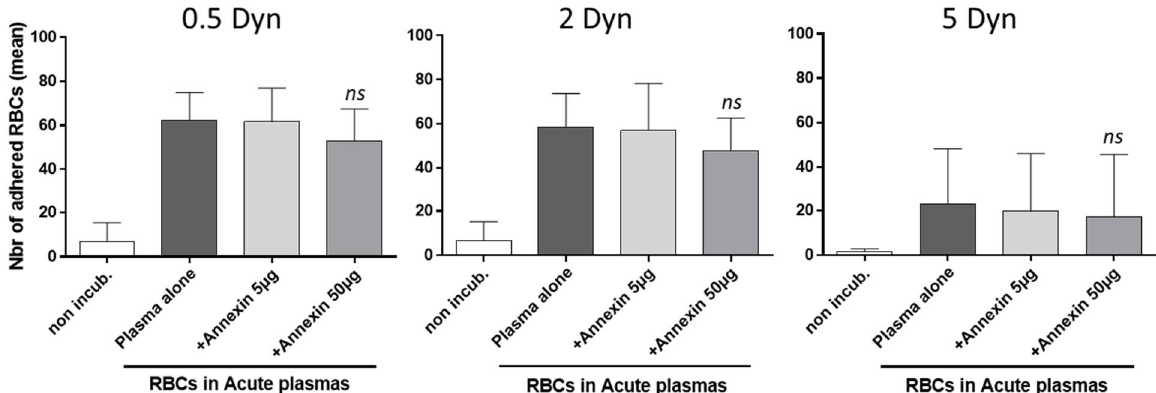
Figure 4. Adhesion results for AA RBCs to thrombospondin, whose senescence is induced by acute SCD plasmas, is not blocked by Annexin V. The adhesion of AA RBCs from blood units was tested under physiological in-flow conditions after co-incubations with plasmas from SCD patients into severe “acute” clinical conditions, using Vena8 microslides coated with TSP. RBCs were washed and resuspended in the Ca 2+ containing buffer from the kit, before processing the adhesion assay. Recombinant Annexin V (5 and 50 μg) was then added before perfusion to inhibit adhesion. We previously verified that the addition of recombinant Annexin V (5–10 μg) to fresh normal RBCs was sufficient for blocking the positive staining with Annexin V-FITC of PS-positive AA RBCs treated with the calcium ionophore A23187 (data not shown). After washouts at increasing shear stresses (first 0.5, then 2 and finally 5 Dyn/cm 2 ), adherent red cells were counted. The means of adhesion for non-incubated RBCs were 6.8 ± 8.6 for the 0.5 Dyn shear stress, 6.7 ± 8.5 (2 Dyn) and 1.6 ± 1.2 (5 Dyn), respectively. For the RBCs incubated with plasmas alone, results were 62.4 ± 12.4 (0.5 Dyn), 58.5 ± 15.1 (2 Dyn) and 23.1 ± 25.1 (5 Dyn), respectively. These results for adherence were not significantly different to the adherence obtained for the condition +Annexin 50μg; 52.9 ± 14.9 (0.5 Dyn), 47.8 ± 14.8 (2 Dyn) and 17.1 ± 28.5 (5 Dyn), respectively. Results represent the mean of three independent experiments. Data represent the mean of three to five independent experiments. ns : non-significantly different to the “plasma alone” condition (ratio-paired t test).